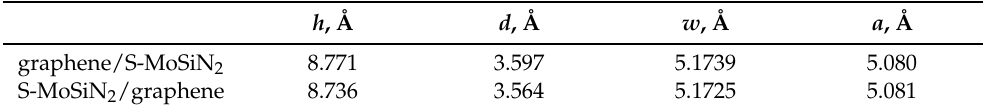
Table 4. Geometric parameters of vdW heterostructures graphene/S-MoSiN 2 and S- MoSiN 2